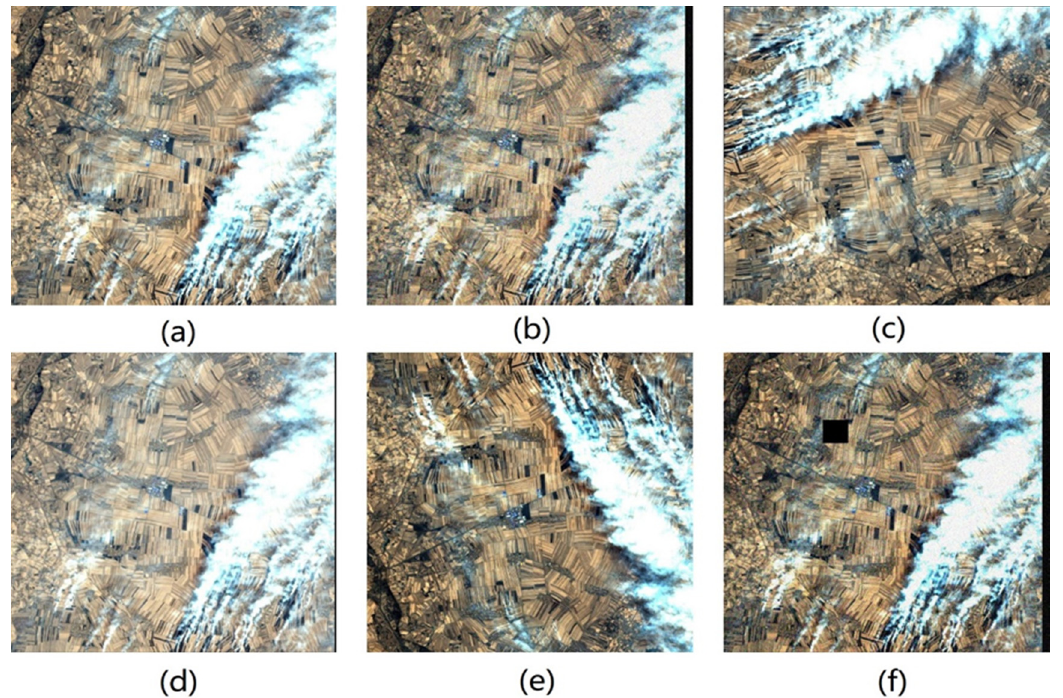
Figure 5. Images of smoke from straw burning after various operations: ( a ) original image, ( b ) after translation + brightness + noise, ( c ) after rotation + brightness + flip, ( d ) after translation + brightness, ( e ) after brightness + flip, and ( f ) after translation + noise + cutout + brightness.